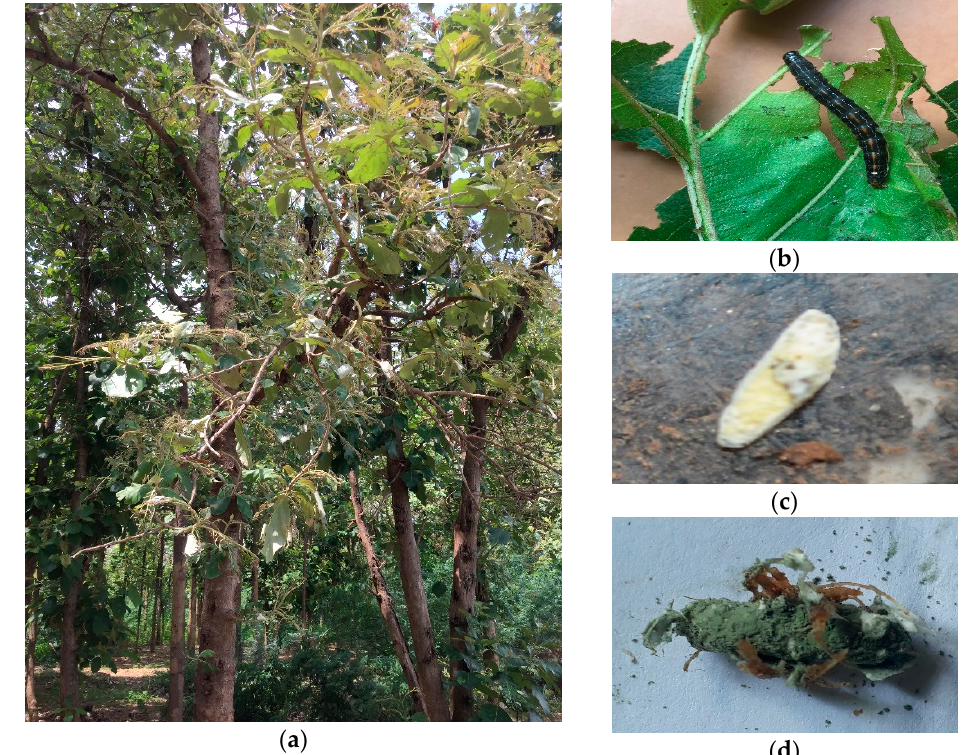
Figure 1. ( a ) Teak forest with H. puera infestation in field, ( b ) H. puera feeding on leaves, ( c ) Dead larvae showing the symptoms of M. quizhouense infection, and ( d ) Insect mummified covered M. robertsii infected cadaver with spores.